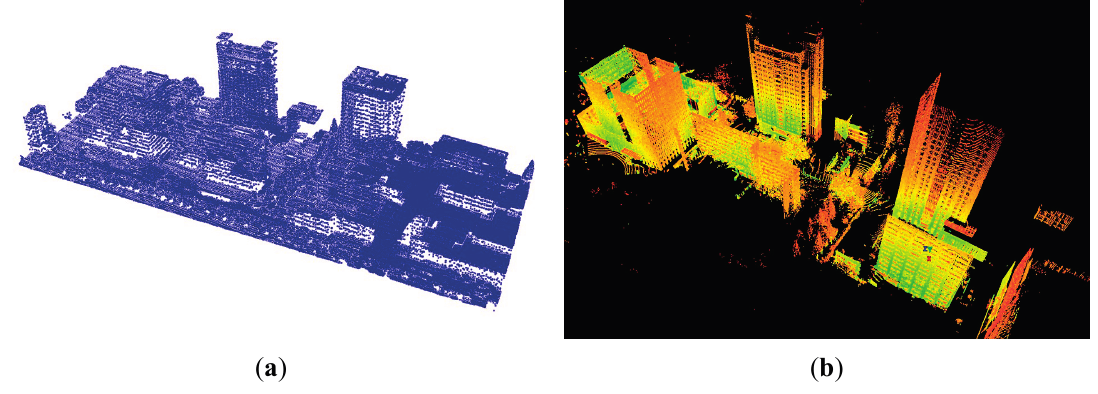
Figure 5. Experimental data. ( a ) Airborne LiDAR data; ( b ) terrestrial LiDAR data (collected by nine terrestrial survey stations manually registered based on